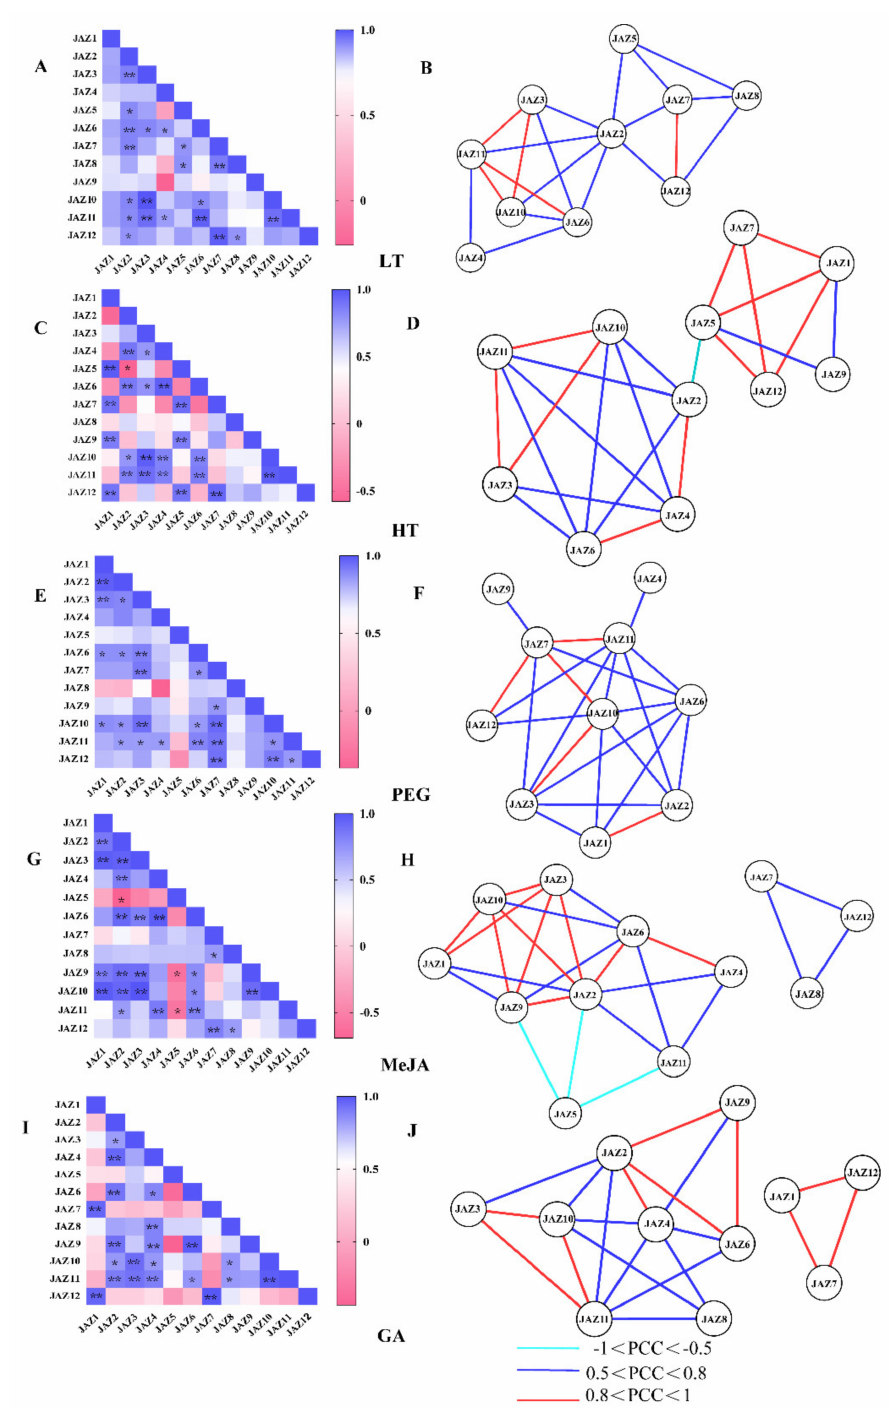
Figure 5. Correlations among CsJAZ genes under LT, HT, PEG, MeJA, and GA treatments. Correlation analysis of CsJAZ genes under LT ( A ), HT ( C ), PEG ( E ), MeJA ( G ), and GA ( I ) treatment was performed based on the PCCs of gene pairs calculated using GraphPad Prism 7 software. Correlations are indicated by the color scales. The lower bar represents the PCC values. * and ** represent correlations with p -value ≤ 0.05 and p -value ≤ 0.01, respectively. The co-regulatory network of CsJAZ under LT ( B ), HT ( D ), PEG ( F ), MeJA ( H ), and GA ( J ) treatment was illustrated by Cytoscape. The significant PCCs of gene pairs ( p -value ≤ 0.05) are included, and the di ff erent correlation levels of the gene pairs are marked by edge lines with di ff erent colors, as shown below the coregulatory